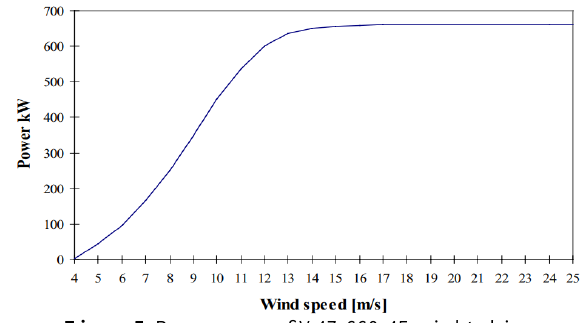
Figure 5 . Power curve of V47-660-45 wind turbine.